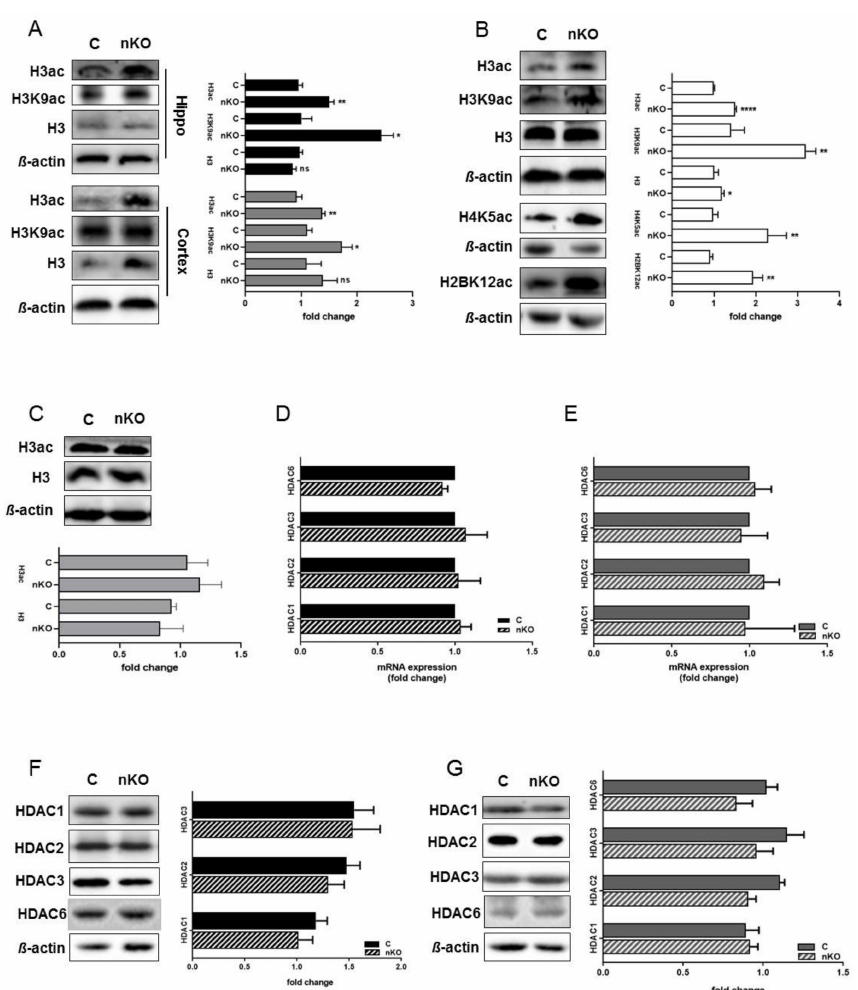
Figure 2. SGPL1 deficiency a ff ects histone acetylation in the brain without a ff ecting histone deacetylases (HDAC)expression. ( A )ProteinquantificationofH3pan-acetylation(H3ac), H3K9acetylation(H3K9ac), andtotalH3inthehippocampus(Hippo, black)andcortex(darkgrey)fromcontrol(C)andSGPL1 fl / fl / Nes (nKO) mice. ( B ) Protein quantification of H3 pan-acetylation (H3ac), H3K9 acetylation (H3K9ac), total H3, H4K5 acetylation (H4K5ac), and H2BK12 acetylation (H2BK12ac) in astrocytes from control (C) and SGPL1 fl / fl / Nes (nKO) mice. ( C ) Protein quantification of H3 pan-acetylation (H3ac) and total H3 in primary neuronal culture from control (C) and SGPL1 fl / fl / Nes (nKO) mice. ( D – E ) qRT-PCR of HDAC1, 2, 3, and 6 in the hippocampus ( D ) and cortex ( E ) of control (C) and SGPL1 fl / fl / Nes (nKO) mice. ( F – G ) Protein quantification of HDAC1, 2, 3, and 6 in the hippocampus ( F ) and cortex ( G ) of control (C) and SGPL1 fl / fl / Nes (nKO) mice. For all: Bars mean +/ − S.E.M, Student’s t -test with false discovery rate (FDR) correction, n = 3 − 7, * q < 0.05, ** q < 0.01, *** q < 0.001, ns = not